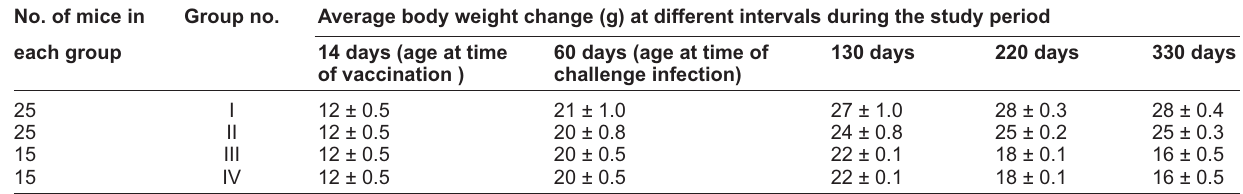
Table-3: Changes in body weight of mice before and after challenge infection in different groups. No. of mice in Group no.